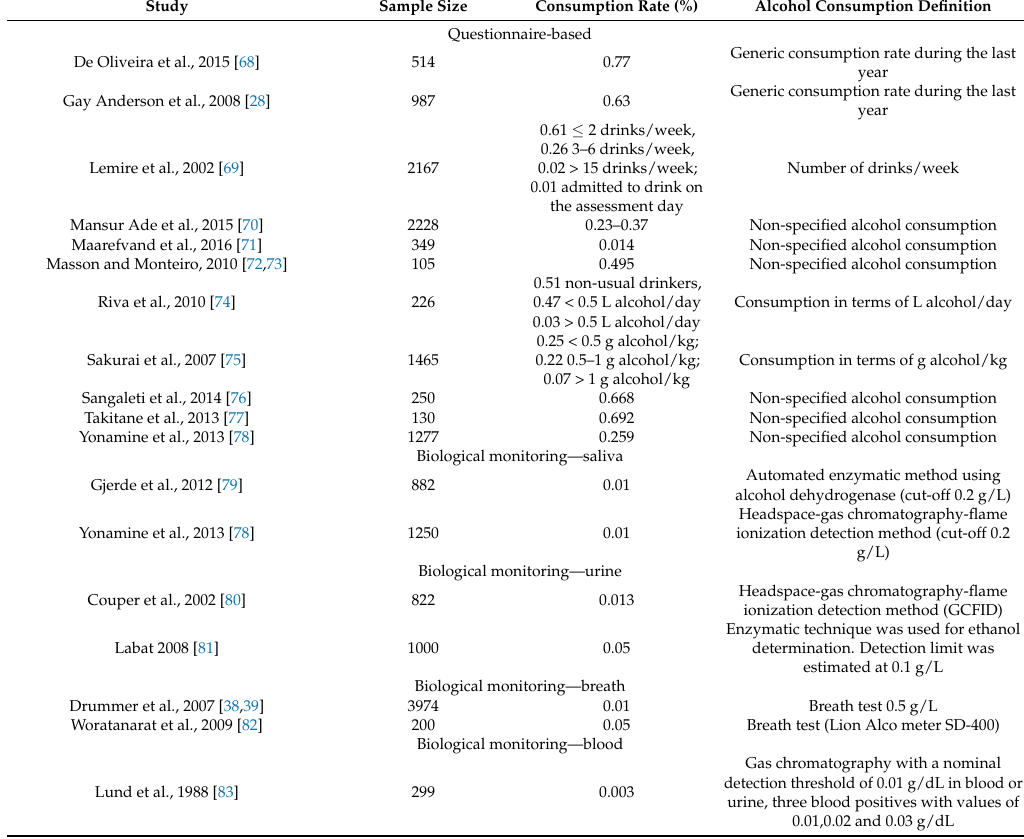
Table 3. Characteristics of the studies excluded with reason from the meta-analysis for methodological heterogeneity related to the definition of alcohol consumption